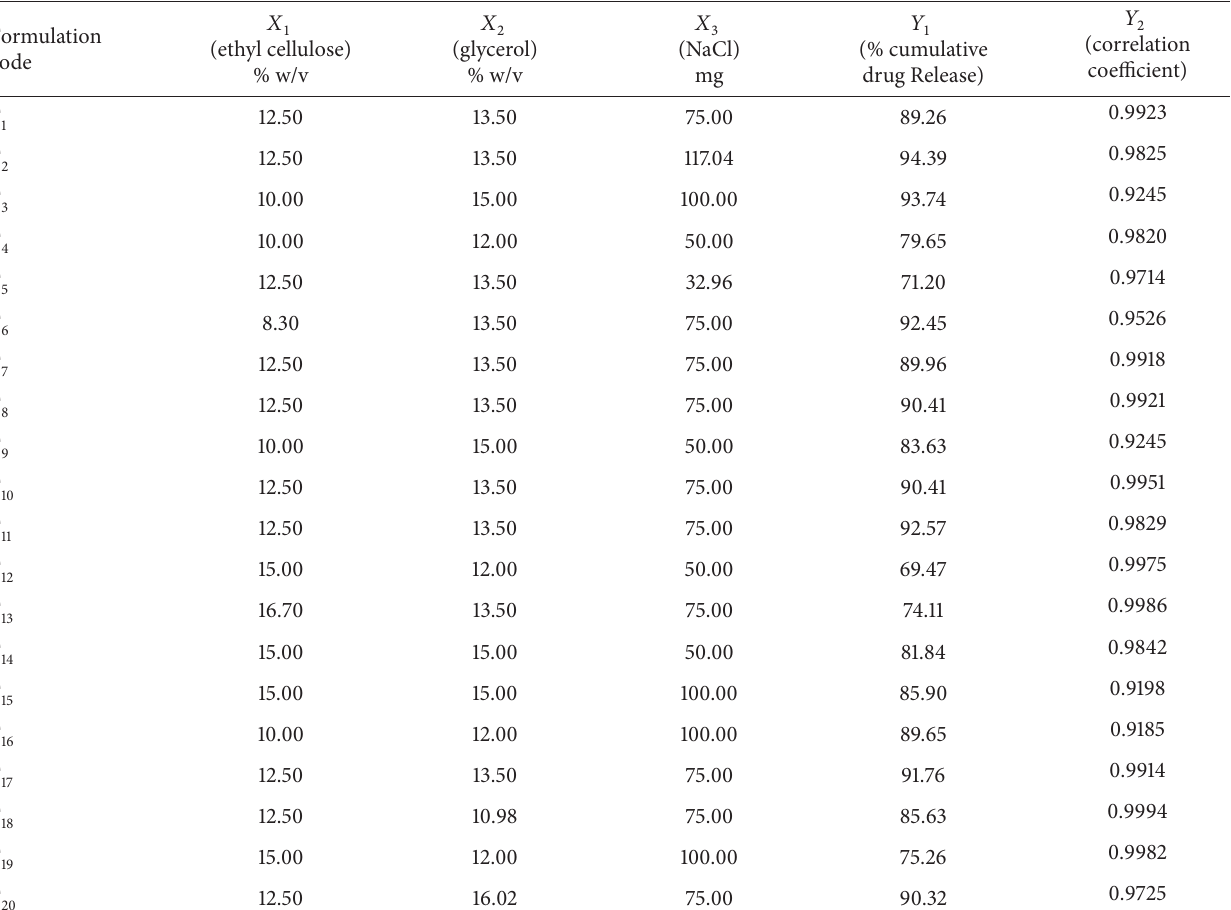
Table 1: Experimental design for three factors and experimental values of